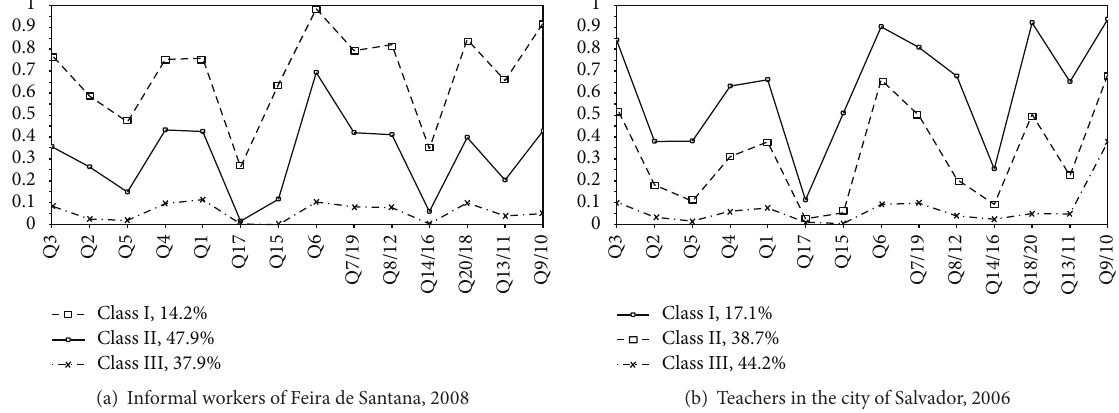
Figure 1: Conditional probabilities of positive responses to SRQ-20 items according to latent class analysis between informal workers and